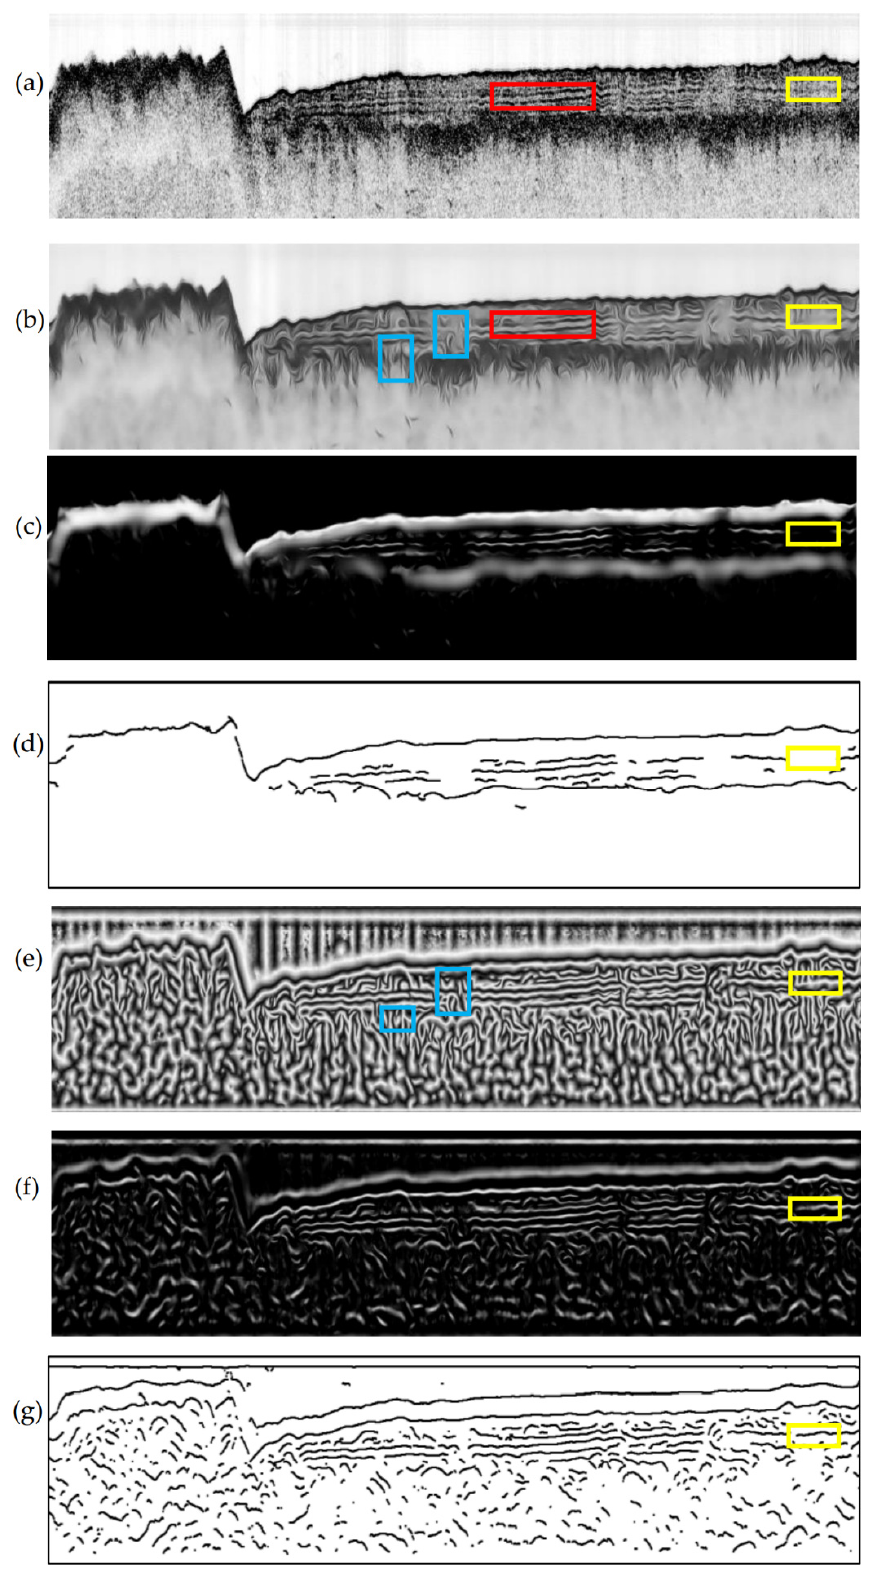
Figure 6. Processed results of SBP image. ( a ) shows the original SBP image. ( b ) shows the SBP image after diffusion filtering. ( c ) shows the image after enhancement filtering based on ( b ). ( d ) shows the main horizons. ( e ) shows the local phase image based on ( b ). ( f ) shows the image after enhancement filtering based on ( e ). ( g ) shows the detailed horizons.